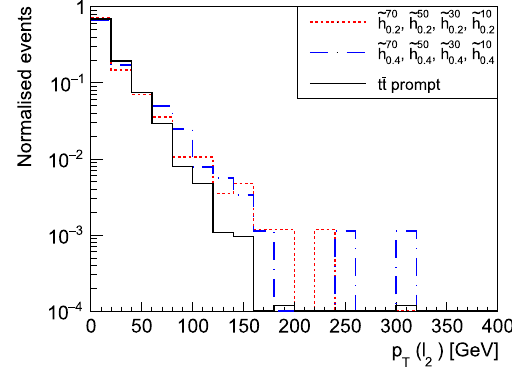
Fig. 33 Missing transverse energy MET in the ˜ h 2 -like case